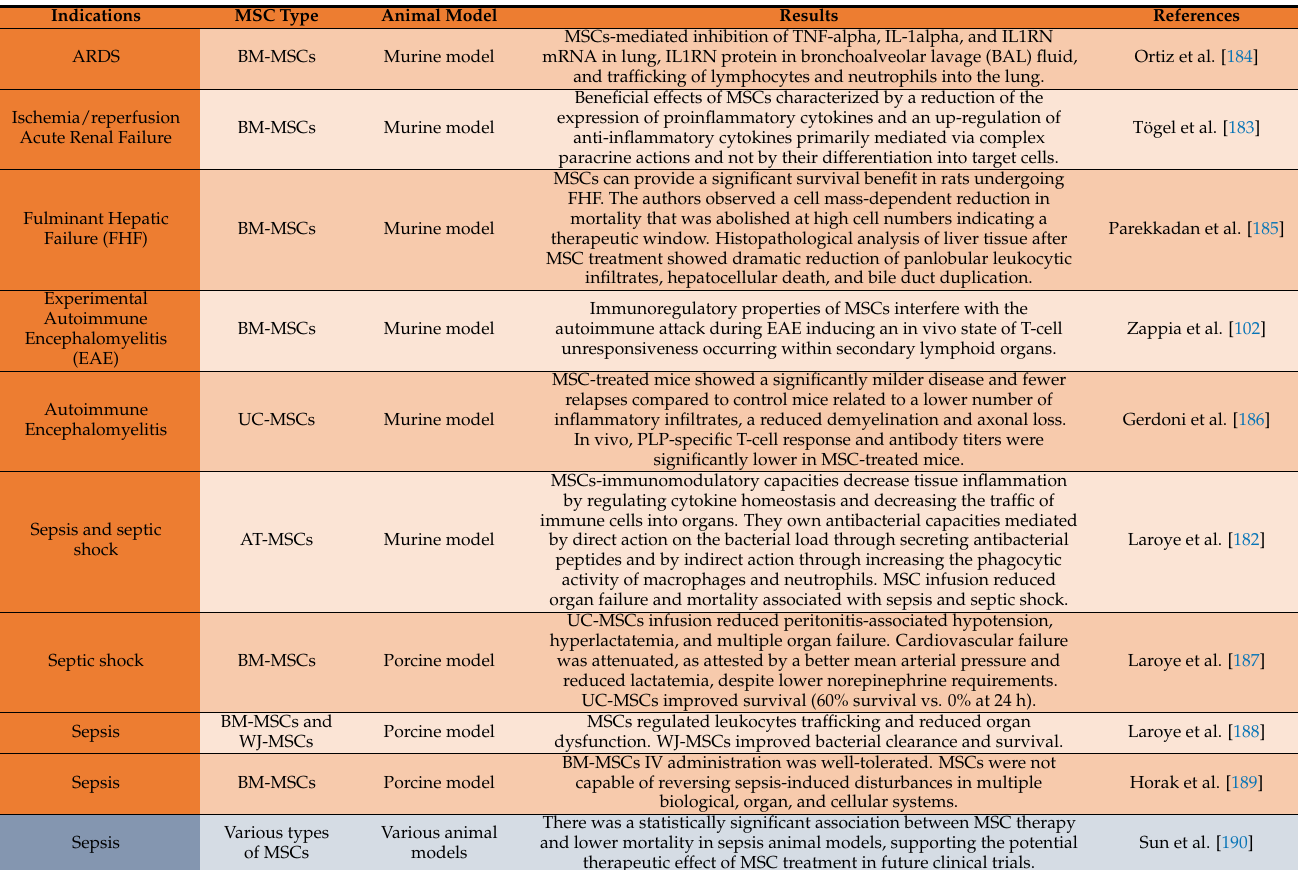
Table 1. A non-exhaustive list of cell therapy MSC-based studies exploring the effectiveness of genetically modified-MSCs infusion in experimental animal models of sepsis or septic